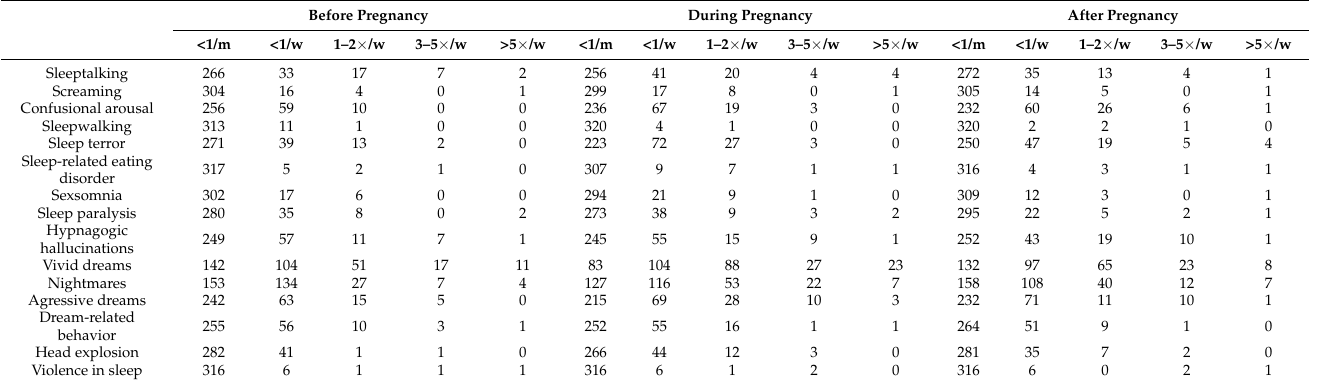
Table 2. Frequency of parasomnia episodes in all the observed time